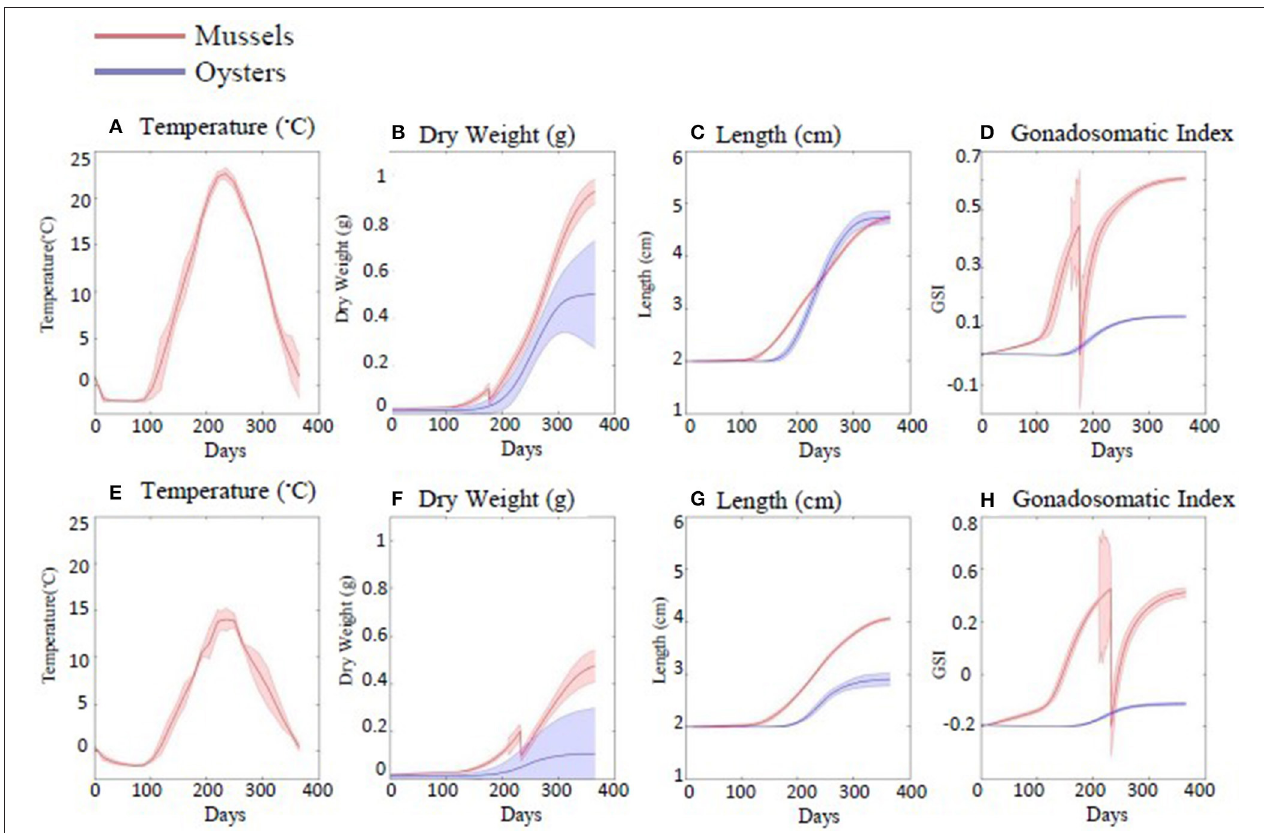
FIGURE 4 | Plots of dynamic energy budget (DEB) output indicating C. virginica and M. edulis growth in dry weight (B,F) , length (C,G) , and gonadosomatic index (D,H) . Over 1 year (beginning on January 1st). This was replicated for areas with two differing thermal regimes, where (A–D) are model outputs from an area with higher average water temperatures than (E–H)